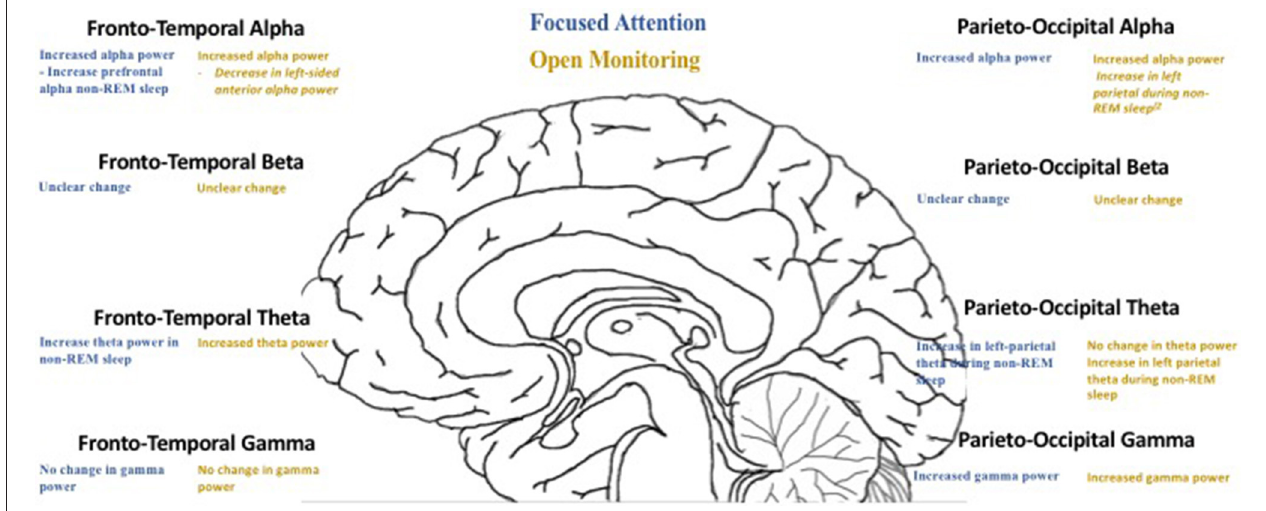
FIGURE 1 | EEG oscillation contrasts between focused attention and open monitoring meditation practices.